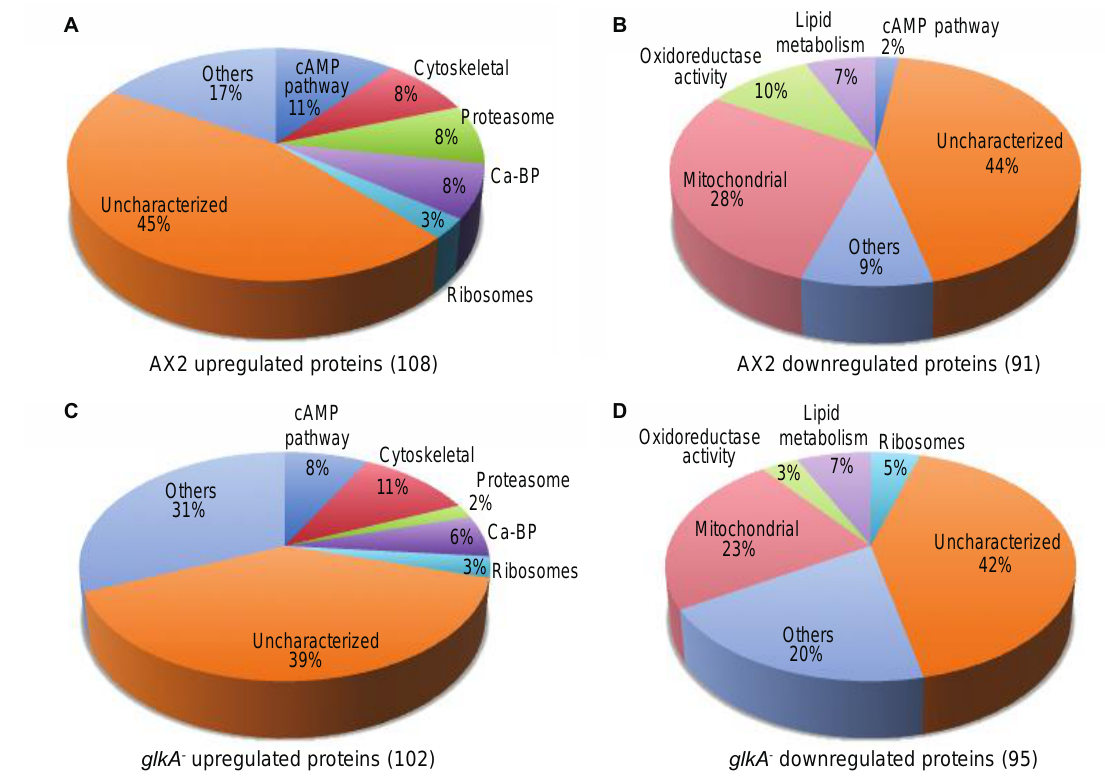
Figure 1. Charts showing differential protein level changes in developed (cAMP-pulsed) versus vegetative (non cAMP-pulsed) wild-type AX2 and glkA null ( glkA − ) cells. Proteins were further classified based on their biological function. ( A ) 108 upregulated proteins in AX2 cells. ( B ) 91 downregulated proteins in AX2 cells. ( C ) 102 upregulated proteins in glkA − cells. ( D ) 95 downregulated proteins in glkA − cells.